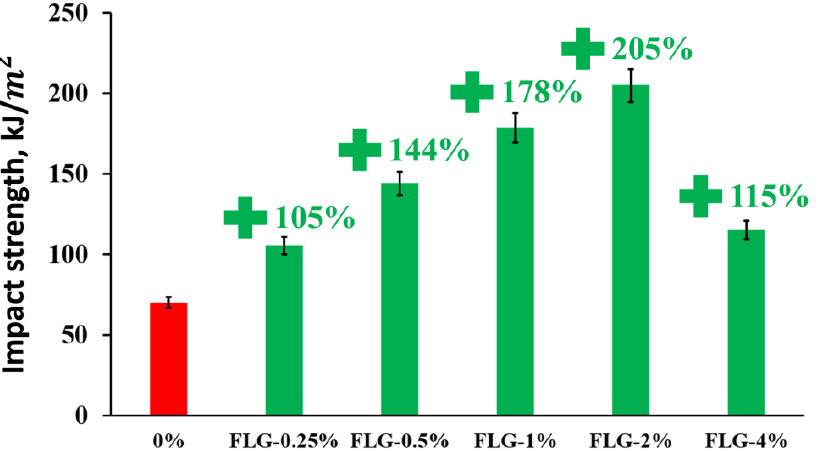
Figure 8. Charpy impact strength of the samples depending on the concentration of FLG.